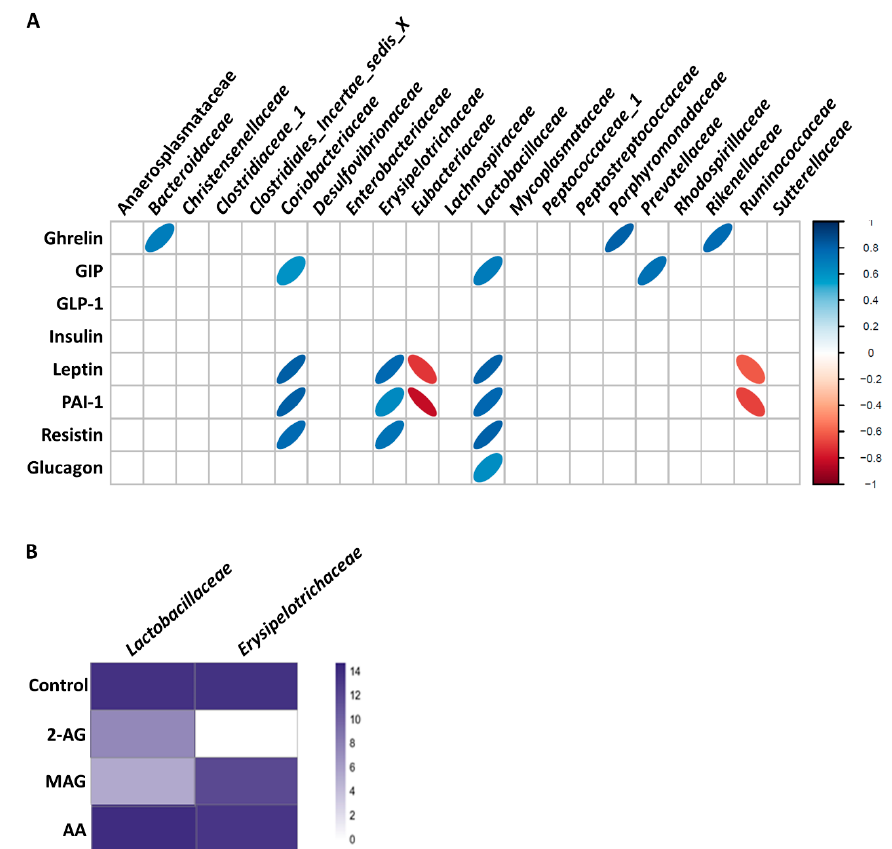
Figure 5. Bacterial families that are di ff erentially abundant within feces of WT and Mgll − / − mice correlate with plasma cytokine levels are sensitive to 2-AG and MAG in in vitro cultures. ( A ) Spearman rho coe ffi cients were used to determine the relationship between bacterial families identified within feces of WT and Mgll − / − mice after 22 weeks of HFD feeding. Ellipses drawn for correlations with p < 0.05. ( B ) Fecal material isolated from the intestine of a WT mouse was cultured in Thioglycolate Broth media (culture condition 12; see supplemental Table S1) supplemented without or with 2-AG (40 µ M), MAGs (40 µ M), or AA (40 µ M) for 3 days. Resulting cultures were sequenced in order to characterize their microbial content and CSS-normalized counts are displayed for families replicating observations made in WT and Mgll − / −